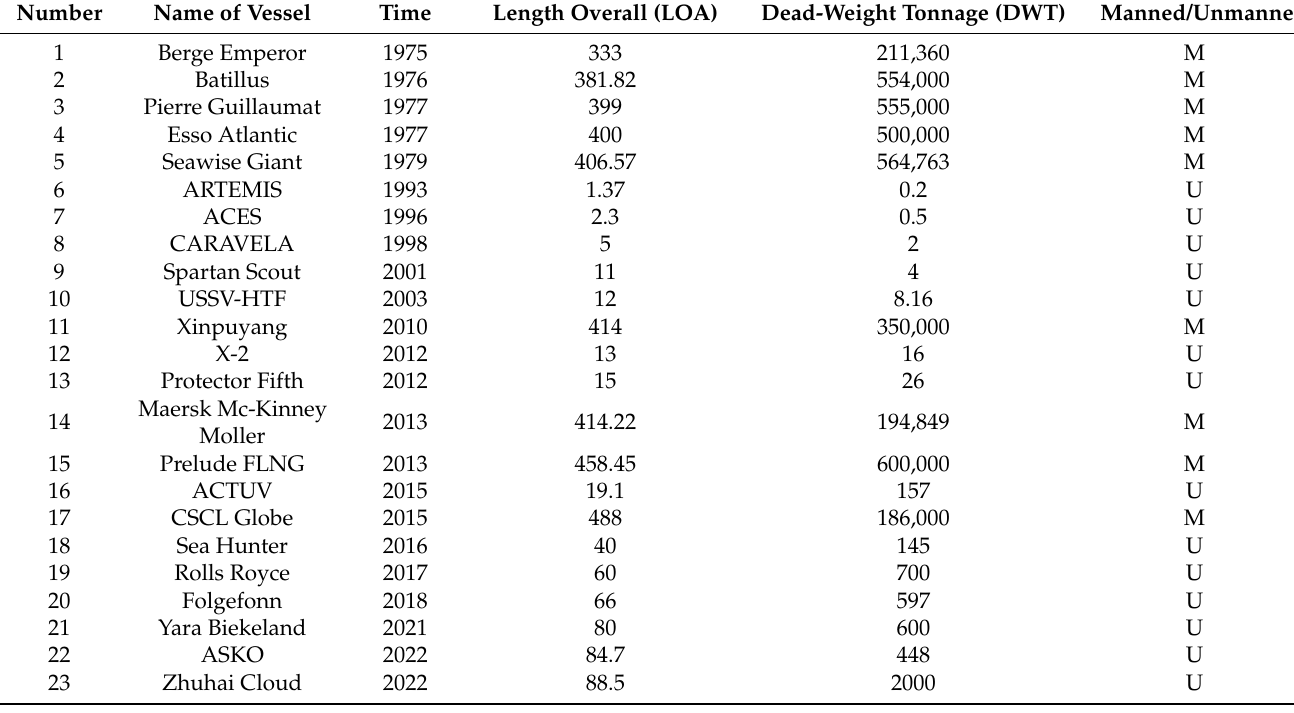
Table 1. MASS (unmanned ship) and manned ship information (1975–2022).